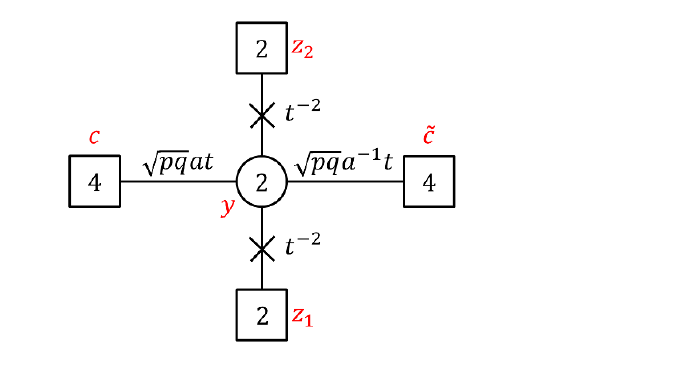
Figure 7 . A quiver of a t-(cid:13)ux tube with (cid:13)ux (cid:0) 1. This tube can be glued using (cid:8)-gluing to the trinion upper SU(2) z maximal